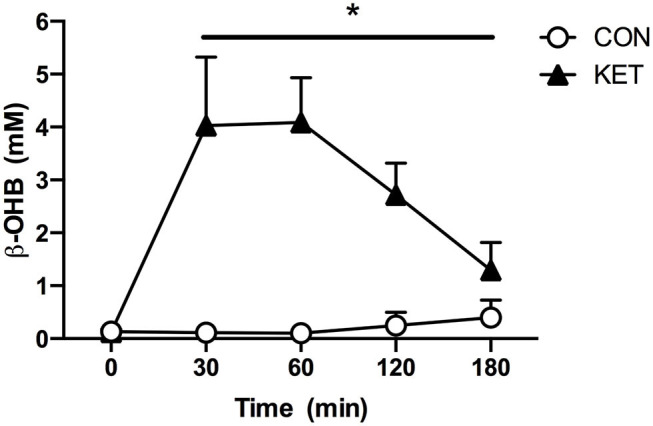
Capillary blood β-OHB concentration (mM) immediately following POST testing prior to treatment intake (t = 0 min) and 30, 60, 120, and 180 min after treatment intake. Values represent means ± SD. *Indicates difference between KET and CON. Data were analyzed with a two-factor repeated measures (within subject factor: time; between-subject factor: group) ANOVA. Bonferroni-corrected post-hoc comparisons were performed following a significant main effect for time or group × time interaction. Time effect: P < 0.001; group effect: P < 0.001; group × time interaction: P < 0.001. β-OHB, beta-hydroxybutyrate; CON, carbohydrate control group; KET, ketone monoester group.